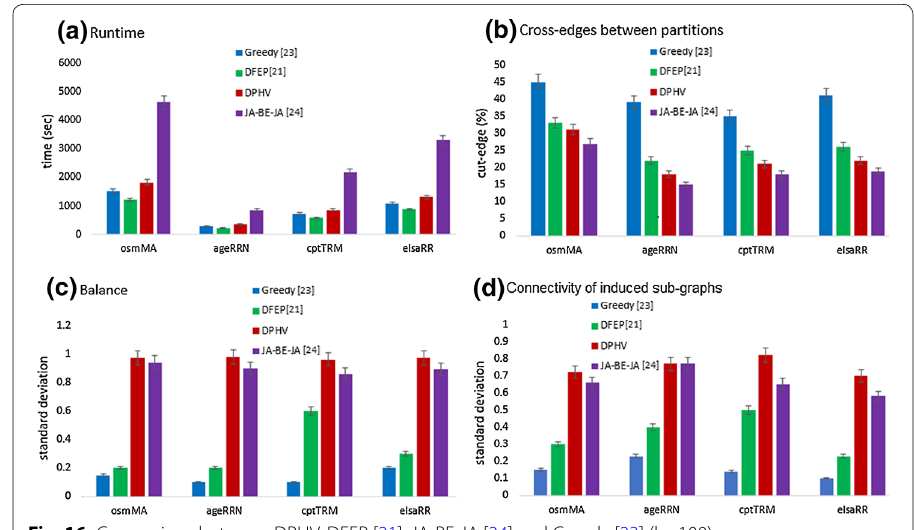
Fig. 16 Comparison between DPHV, DFEP [21], JA-BE-JA [24] and Greedy [23] (k